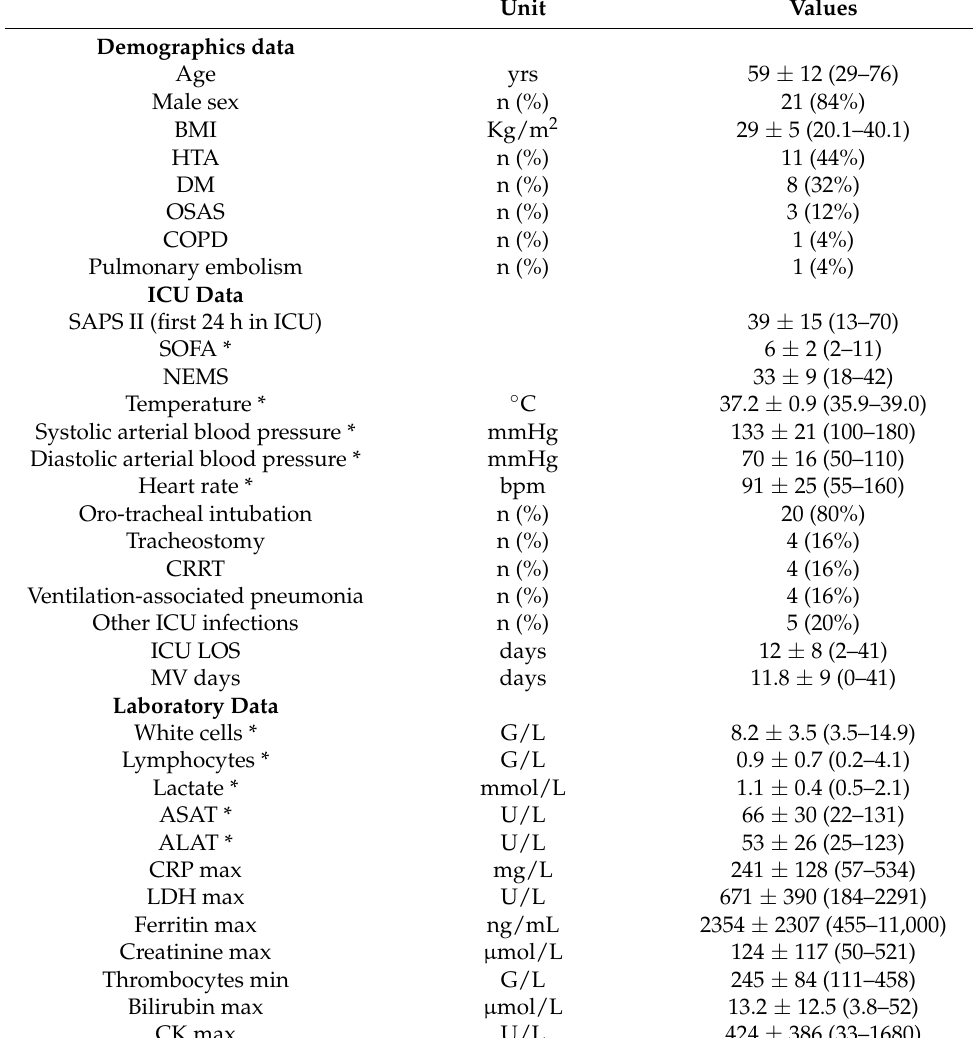
Table 1. Patients’ baseline